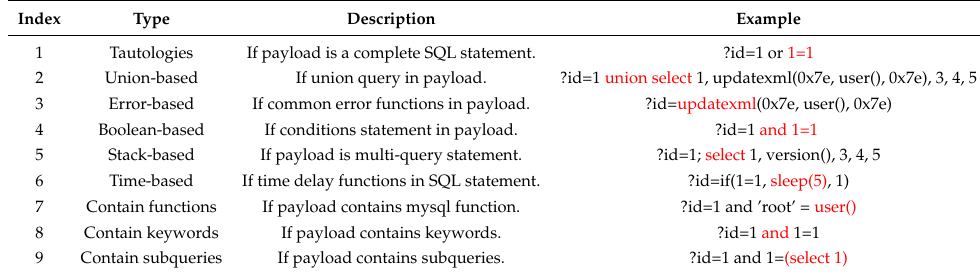
Table 1. Category of SQL